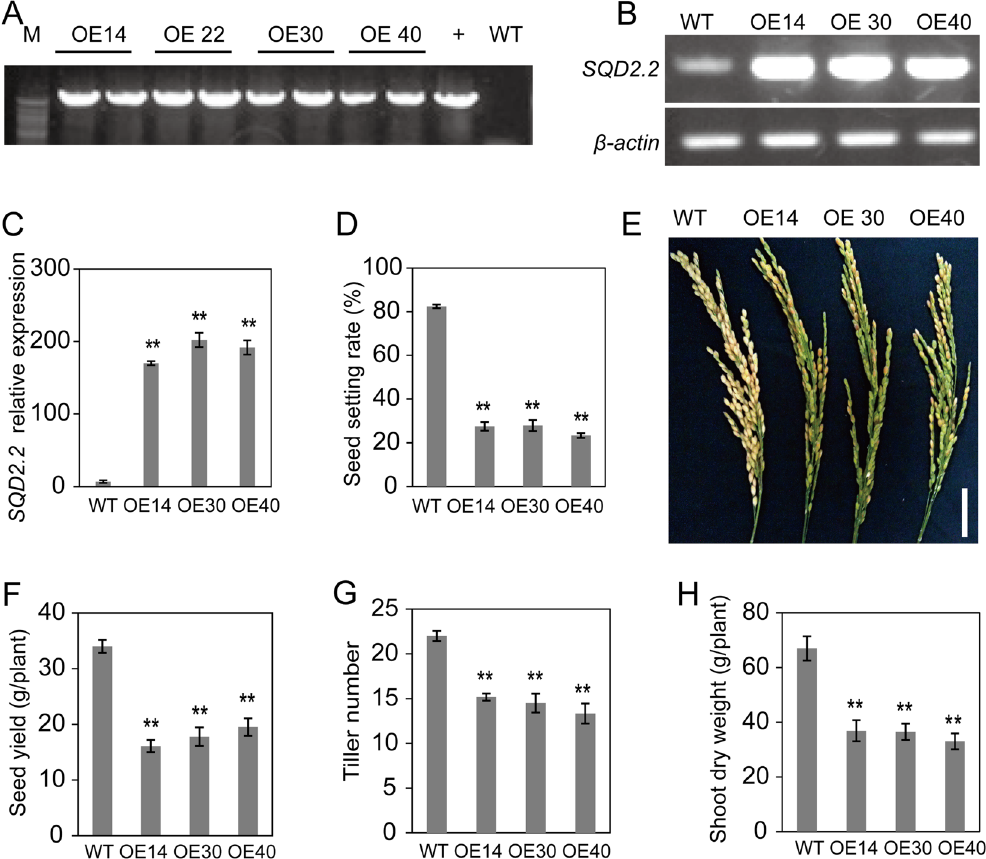
Figure 1. Overexpression of SQD2.2 resulted in a reduced seed setting rate and tiller number. ( A ) Identification of transgenic plants using PCR. ( B ) and ( C ) SQD2.2 overexpression in the transgenic plants was confirmed via semi-quantitative RT-PCR and quantitative real-time PCR. Values are the mean ± standard error (SE) (n = 3). ( D ) and ( E ) Seed setting rate. Values are the mean ± SE (n = 10). ( F ) Seed yield per plant. Values are the mean ± SE (n = 10). ( G ) The tiller number per plant. Values are the mean ± SE (n = 6). ( H ) Shoot dry weight per plant. Values are the mean ± SE (n = 10). Student’s t test; ** P < 0.01. Scale bar = 5